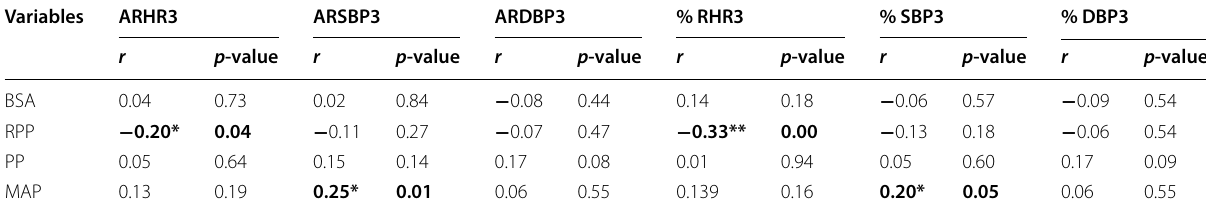
Table 3 Relationship between body surface area, derived cardiovascular indices, and recovery heart rate/blood pressure 3 min after removal of exercise stimulus